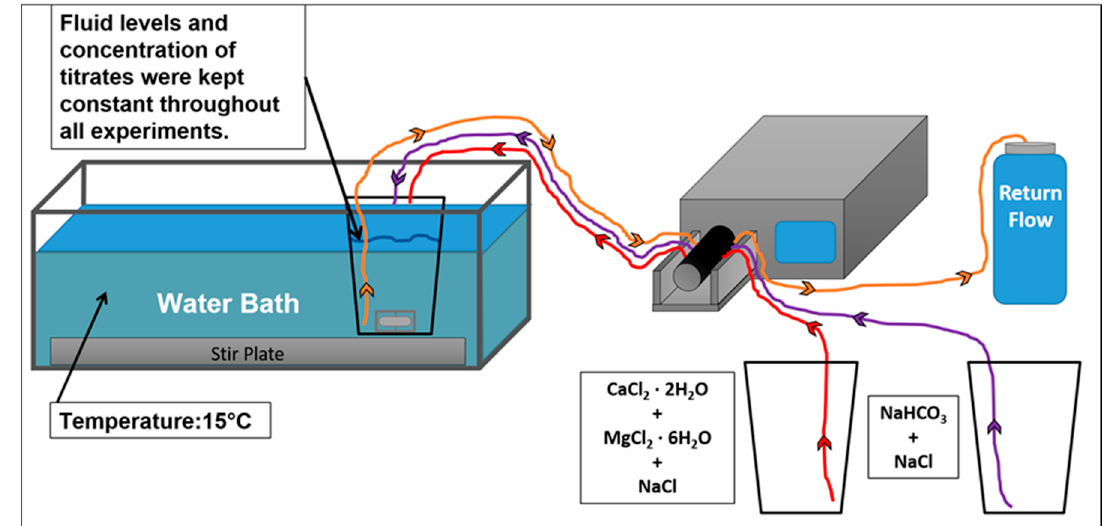
Figure 1. Illustration depicting the experimental set-up for experiments conducted in series 9, 10, and 11. Colored lines and arrows are meant to depict fluid flow directions within tubing.